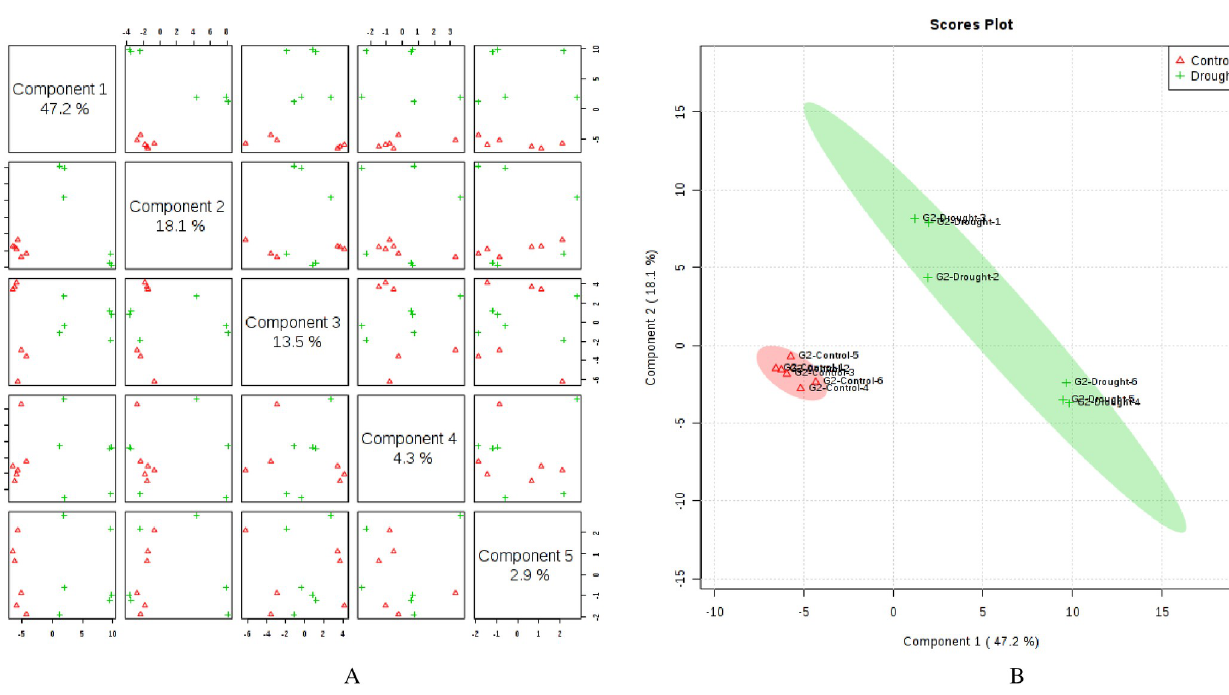
PLOS ONE | https://doi.org/10.1371/journal.pone.0213502 March 11,